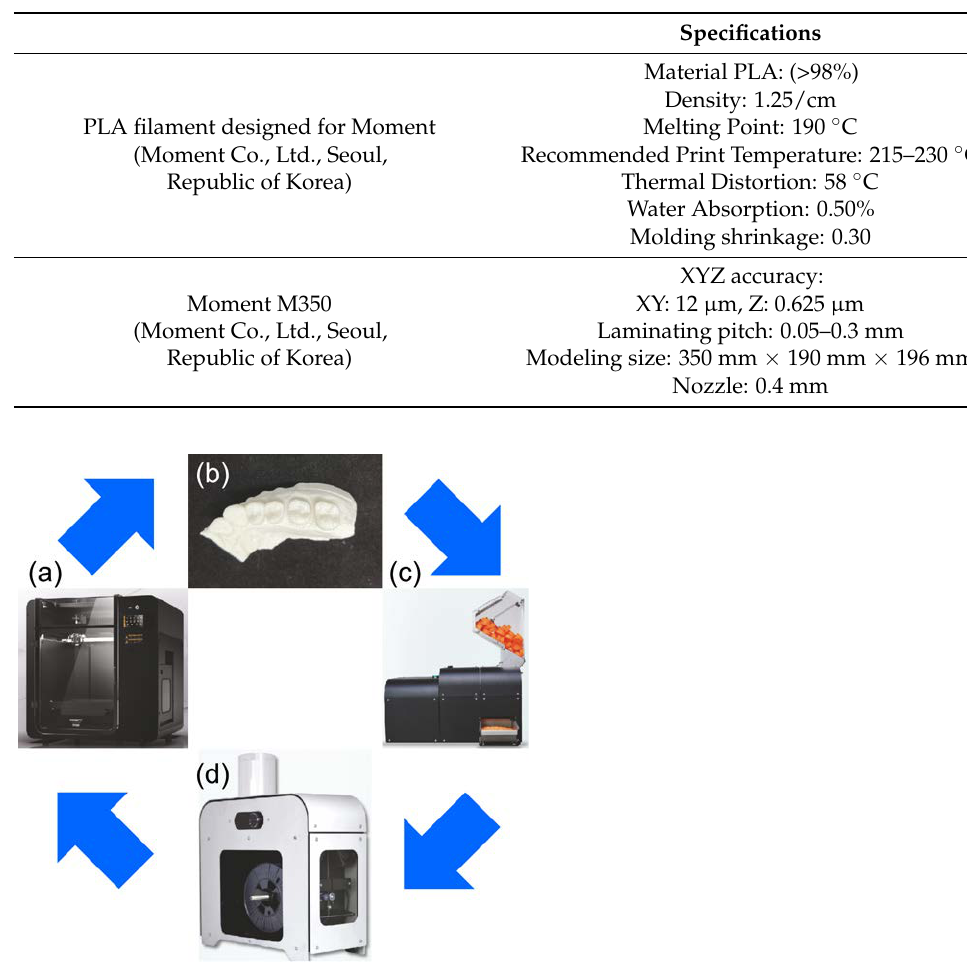
Table 1. Specifications of the filament and 3D printers used in this study.